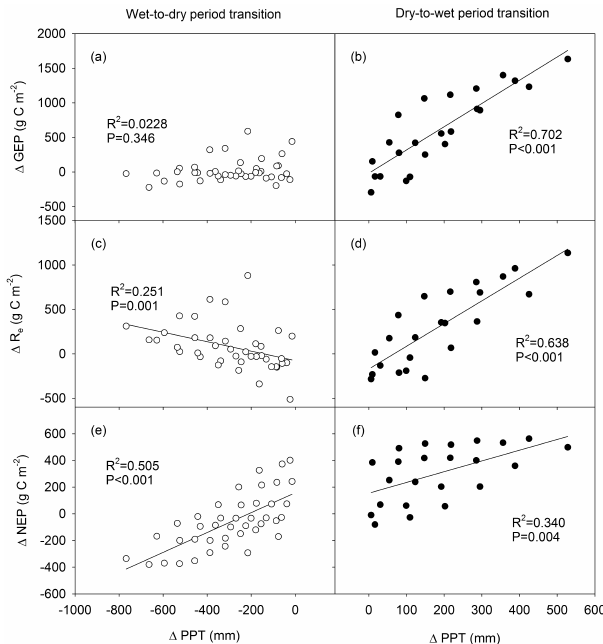
Figure 4. Spearman correlations of interdecadal precipitation legacy effects with the precipitation difference between periods ( (cid:49) PPT). Interdecadal (cid:49) PPT is calculated as the mean PPT of the current period (1995–2010) minus that of the previous period (1981–1994). Interdecadal legacy effects on carbon fluxes (e.g., (cid:49) NEP) are calculated as the difference between the current-period flux with previous-period PPT changes and that without previous- period PPT changes. Sample size is 41 for the wet-to-dry period transition (left panels) and 23 for the dry-to-wet period transi- tion (right panels). GEP represents gross ecosystem production, R e ecosystem respiration, and NEP net ecosystem production. R 2 is the coefficient of determination, and P is